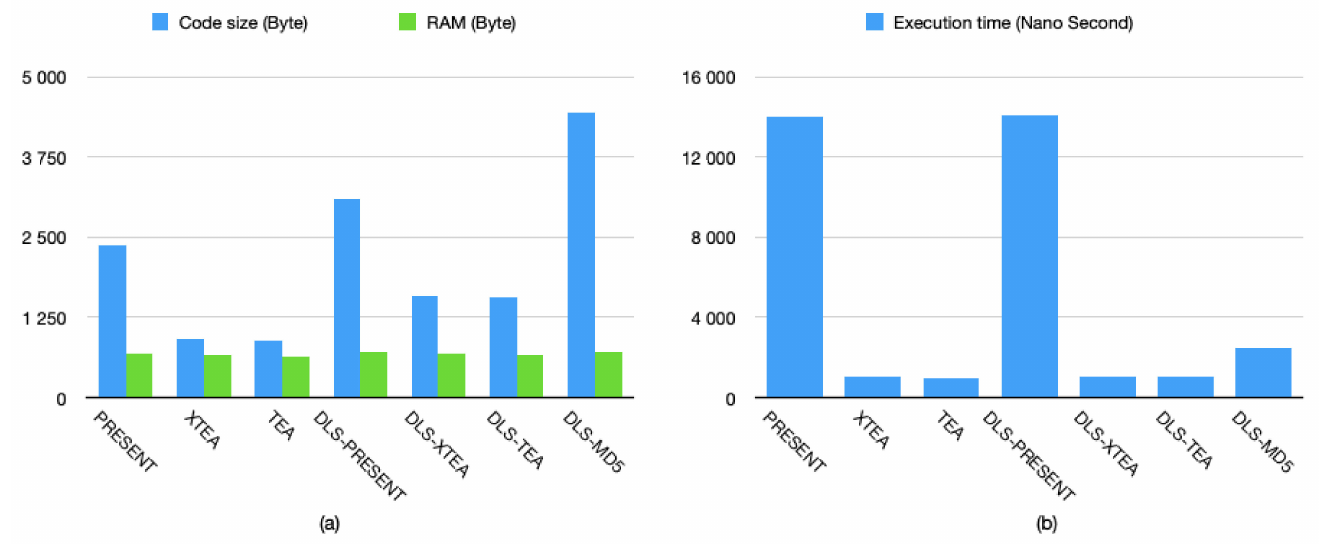
Figure 8. The average resource consumption for different encryption algorithms. ( a ) Code size and memory, and ( b ) Execution time. Table 7. The power consumption on an AiR node for different encryption algorithms. Encryption